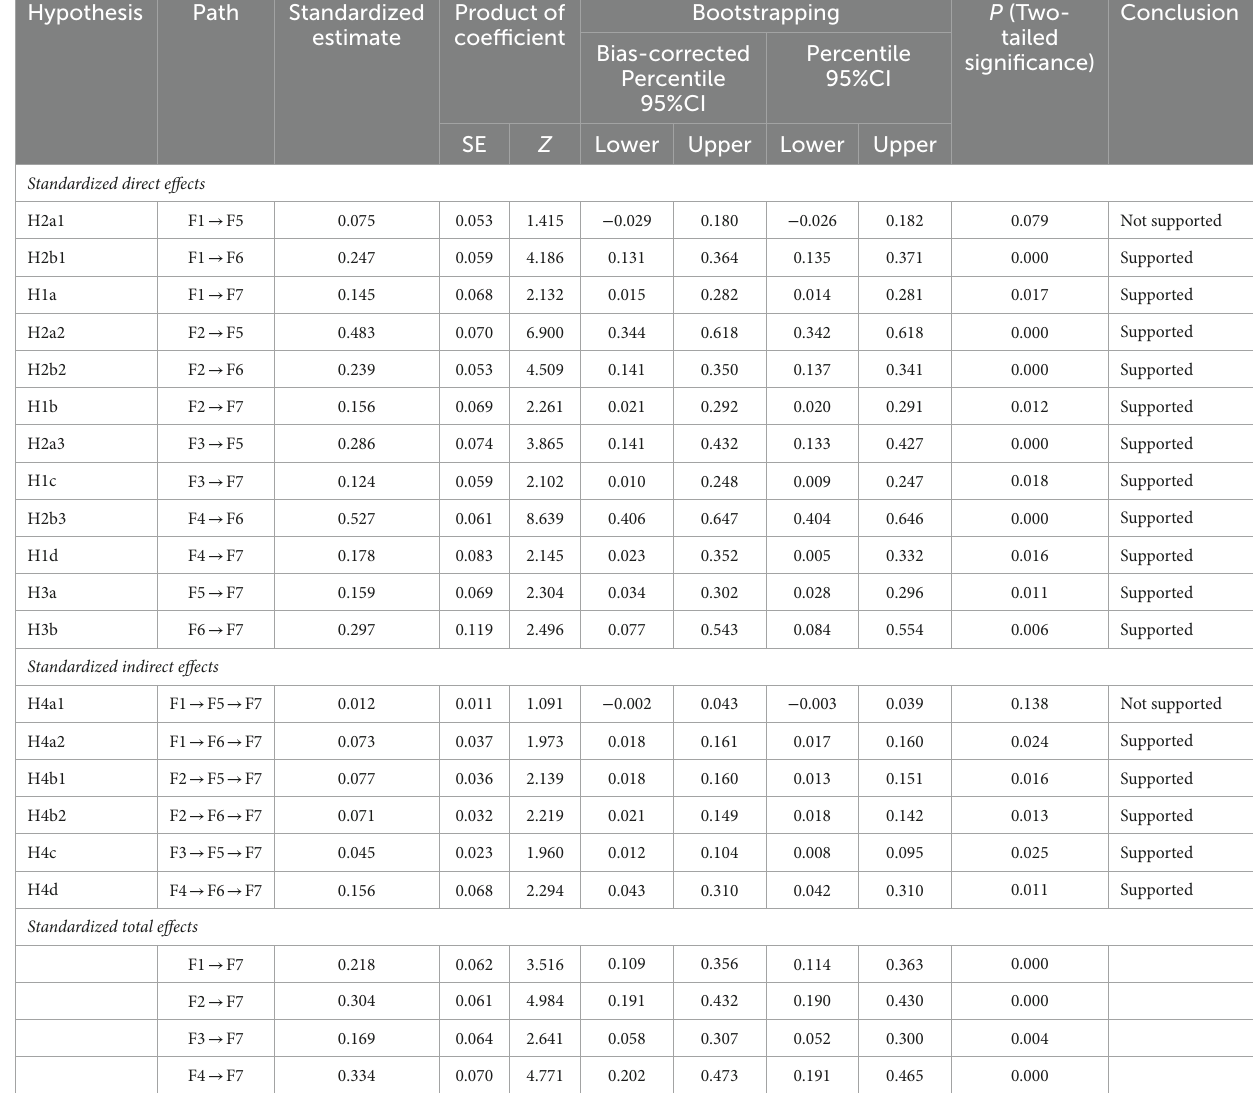
TABLE 4 Direct, indirect and total effects of the standardized hypothesis